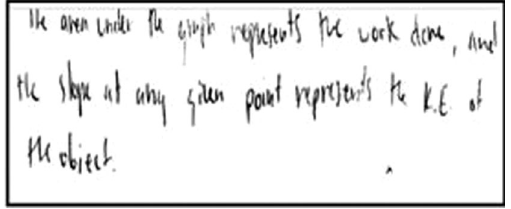
FIG. 15. Interpretation of force-position graph (question